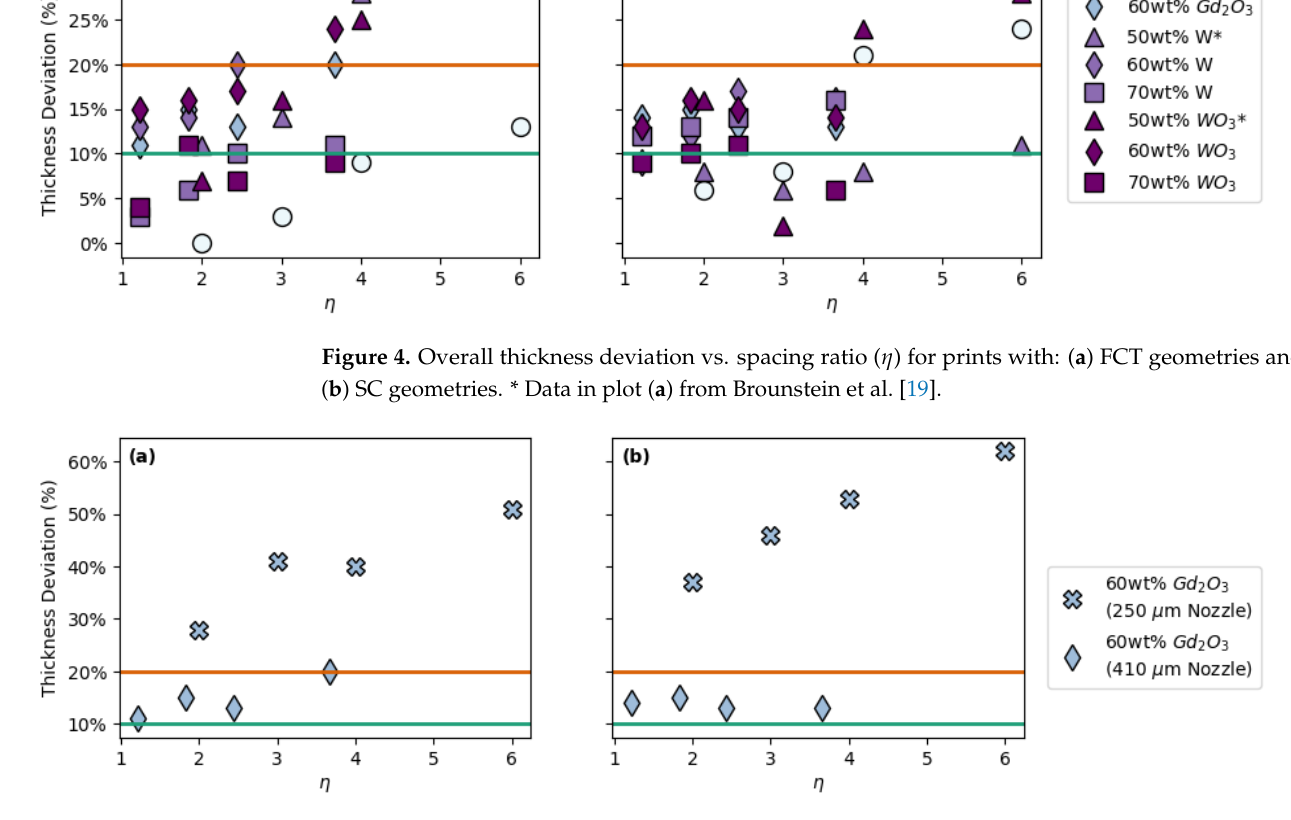
Figure 5. Overall thickness deviation vs. spacing ratio ( η ) for 60 wt% Gd 2 O 3 prints using 250 µm and 410 µm nozzles with: ( a ) FCT geometries and ( b ) SC geometries.